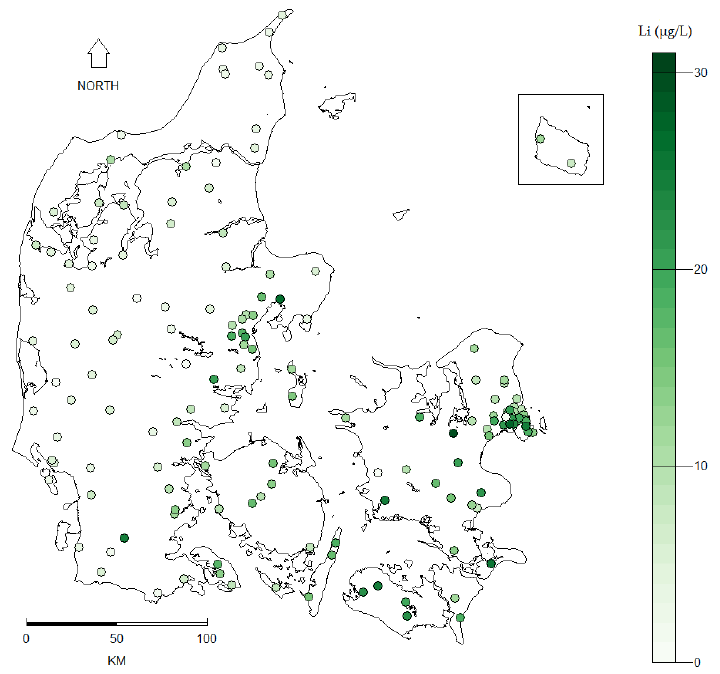
Figure 1. Level and geographic distribution of 151 drinking water lithium (Li) measurements sampled at Danish waterworks between 2009 and 2013.